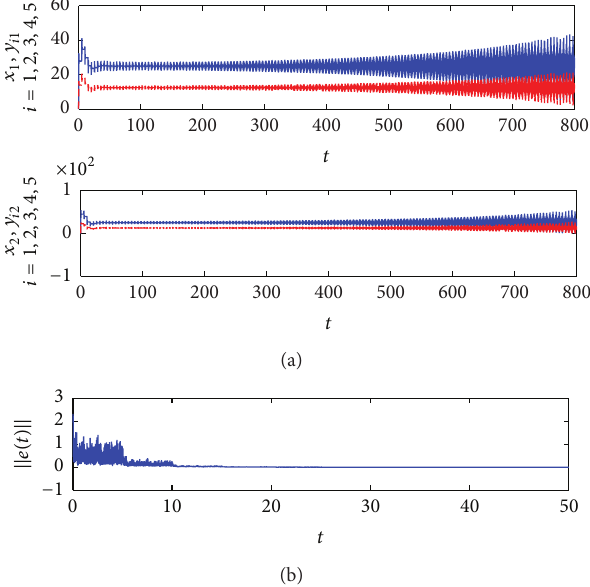
Figure 4: Evolution of (a) state trajectories of drive (the dash line) and response systems (the solid line) and (b) projective synchronization error under impulsive